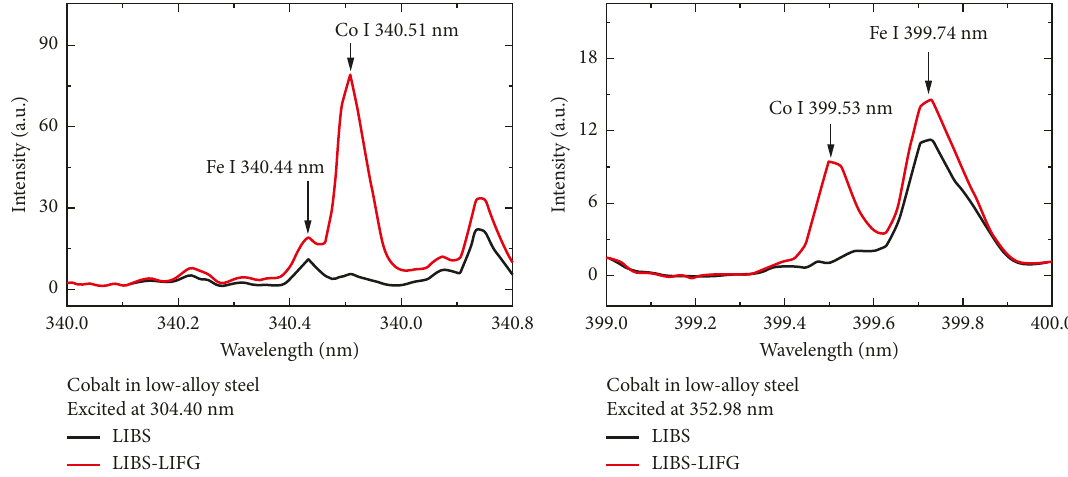
Figure 8: Comparison between LIBS-LIFG, LIBS-LIFE, and LIBS-only spectra for the low-alloy steel sample